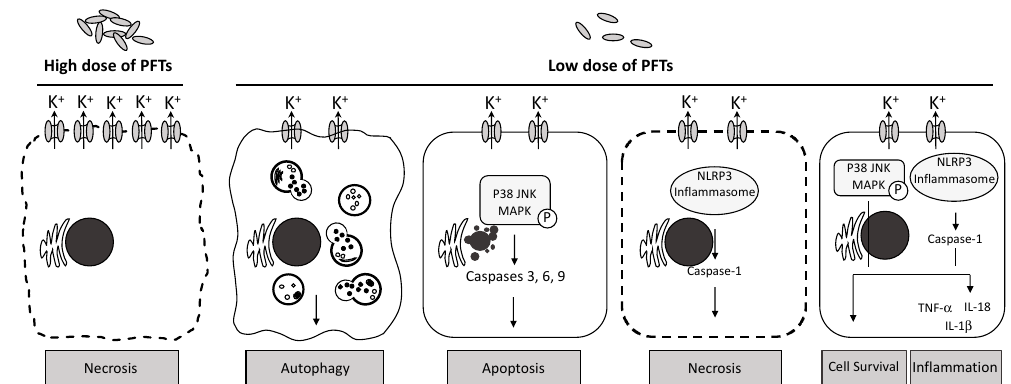
Figure 1. Host cellular responses to the low and high concentrations of cnidarian PFTs. Pore formation of cnidarian PFTs may lead to difference cellular responses in host cells. At high doses of PFTs, multiple pores in the cell membrane cause an imbalance between intra- and extracellular osmotic pressures, resulting in sudden cell burst. Lower doses of PFTs can induce the intrinsic defense mechanism—autophagy that promotes intracellular engulfment and degradation. If the damage to the cell membrane cannot be repaired, the cell may undergo either programmed cell death (apoptosis) or NLRP3-dependent programmed necrosis, through p38 MAPK or NLRP3 inflammasome pathway, respectively. These two signaling pathways are also involved in either the cell survival with the restoration of intracellular osmotic environment or the activation of the cellular innate immune response, releasing pro-inflammatory proteins. In certain circumstances, inflammation is followed immediately by apoptosis or necrosis.